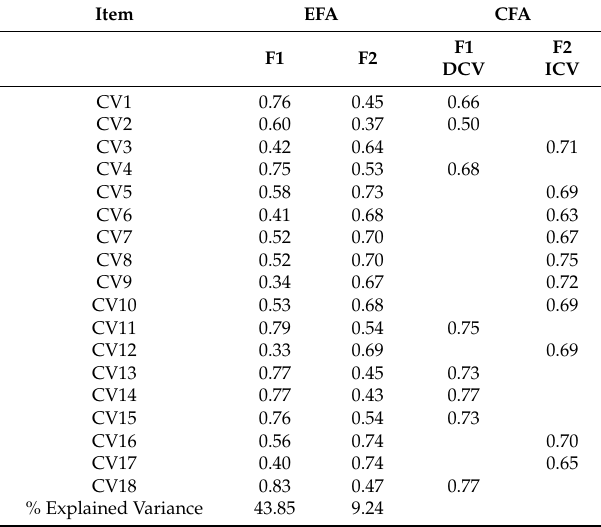
Table 2. Factor loadings for the EFA and CFA.